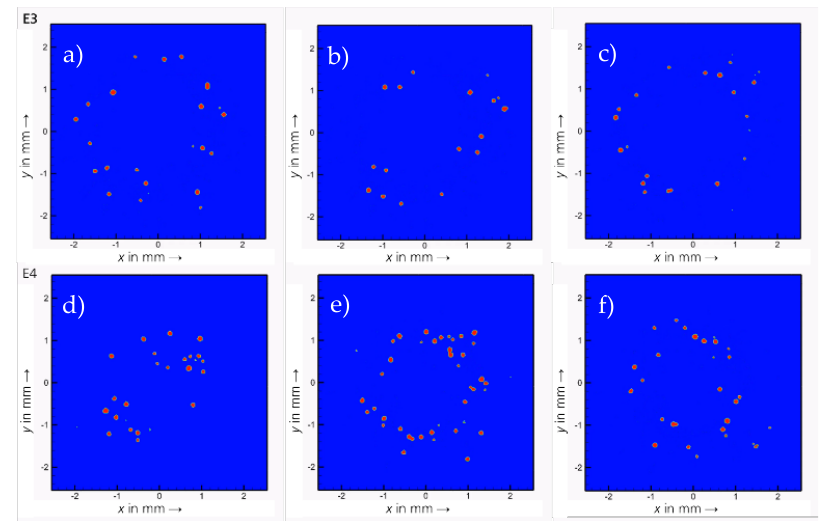
Figure 11. Diagrams of particle identification for each image based on a threshold for the grayscale value of the individual images. Parameters: grain fraction − 53 + 20 µ m, V SG = 10 L / min, ( a – c ): Level E3; ( d – f ): Level E4 [1]. Reprinted with permission from Ref [1]. Copyright 2020, Fraunhofer